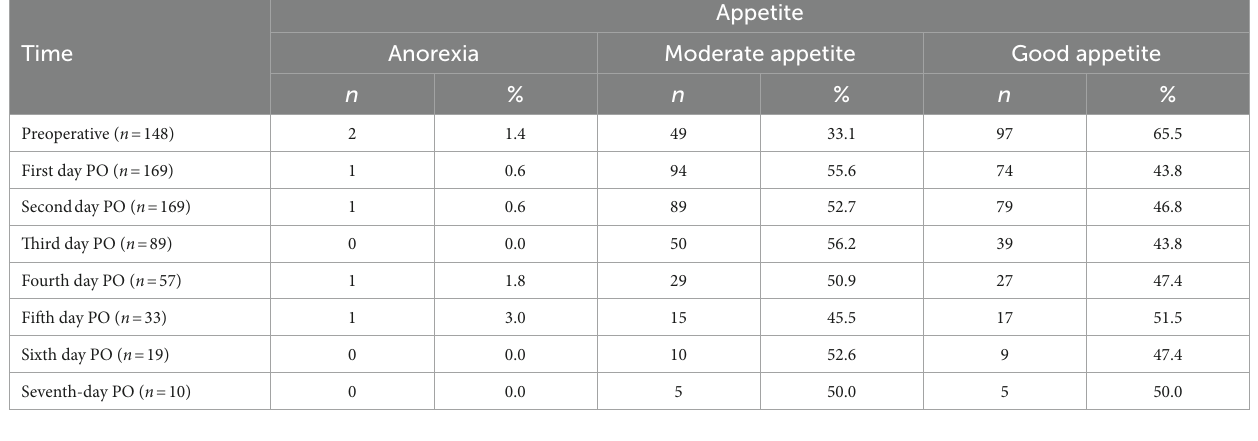
TABLE 2 Appetite status of patient from the preoperative day to postoperative days.